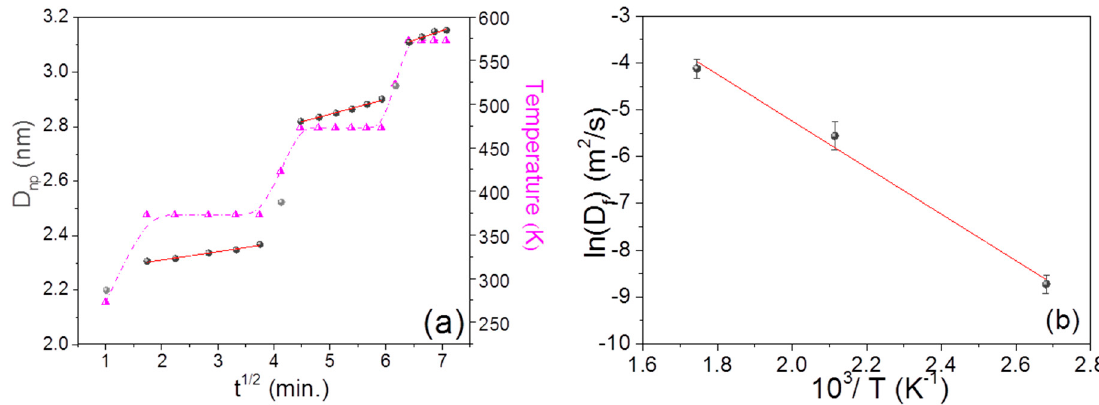
Figure 3. ( a ) Crystalline size (from GIWAXS) variation in Au/PPFC_3 as a function of annealing time (cid:3435)√𝑡(cid:3439) at varying temperature; the dotted (pink) curve represents the temperature profile of the sample with time and temperature ( b ) Arrhenius plot showing the relationship between ln( D f ) (where, D f is the diffusion constant) and 10 3 /T for the Au/PPFC_3 ML obtained from in situ temperature-dependent in-plane GIWAXS.